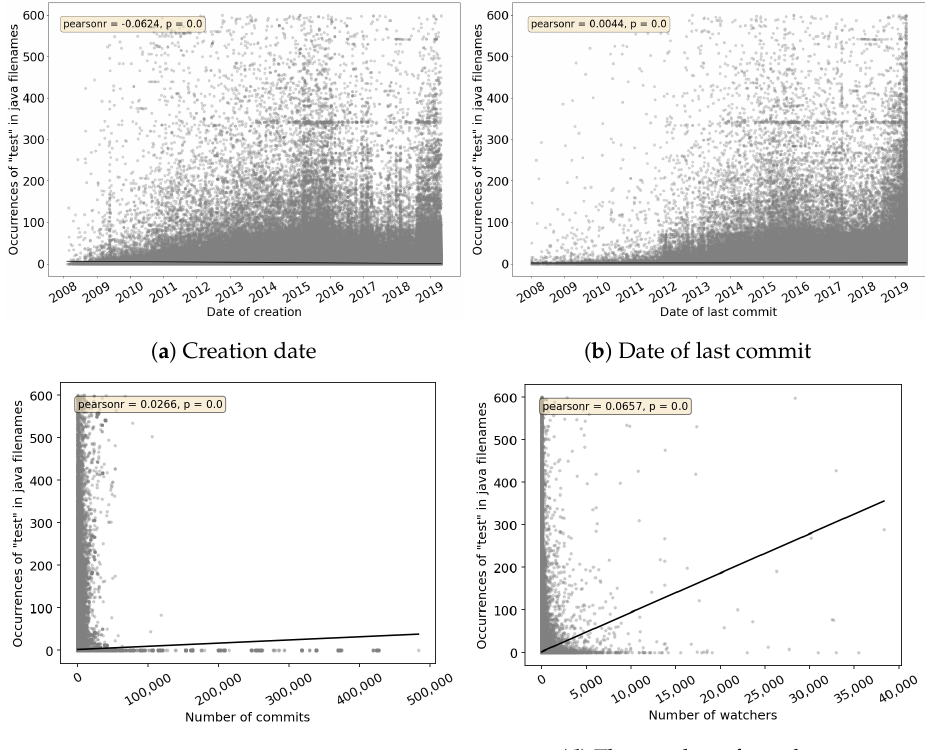
Figure A5. Correlation between the number of occurrences of the word “test” in java files filename and project’s life cycle